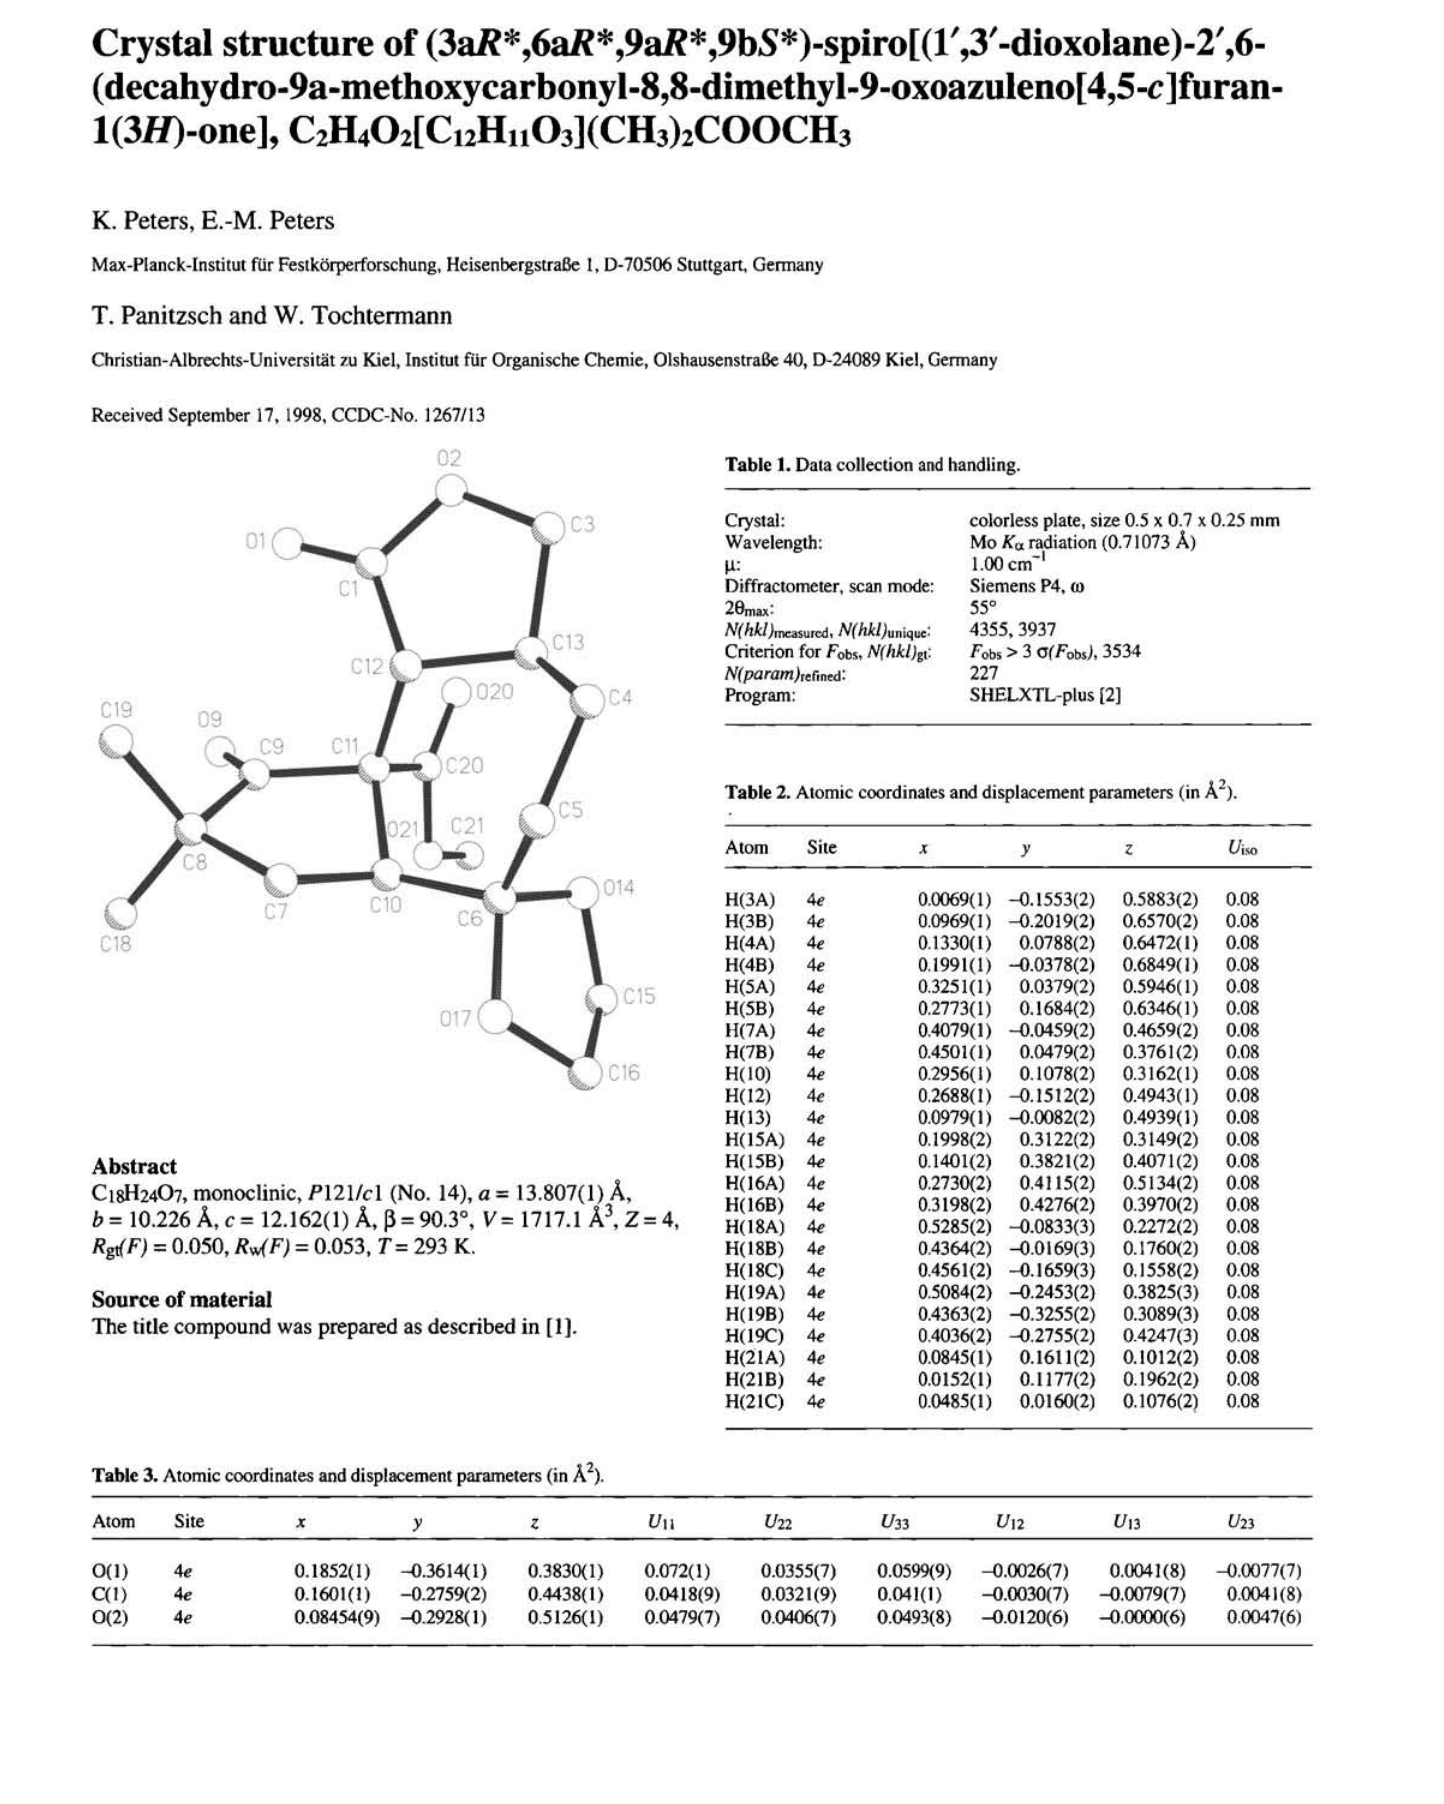
Table 1. Data collection and handling. Crystal: